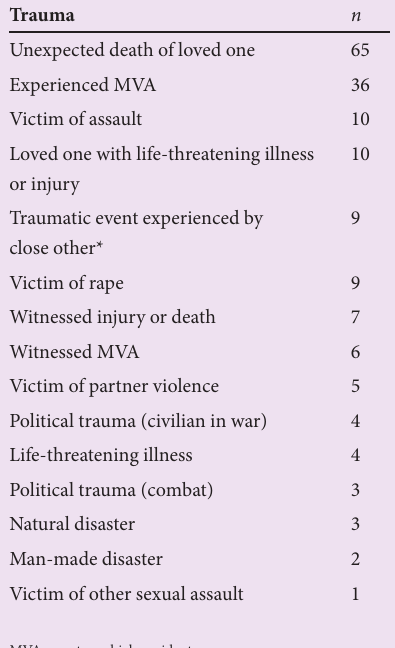
Table 2. Traumatic events experienced prior to entry into the police force